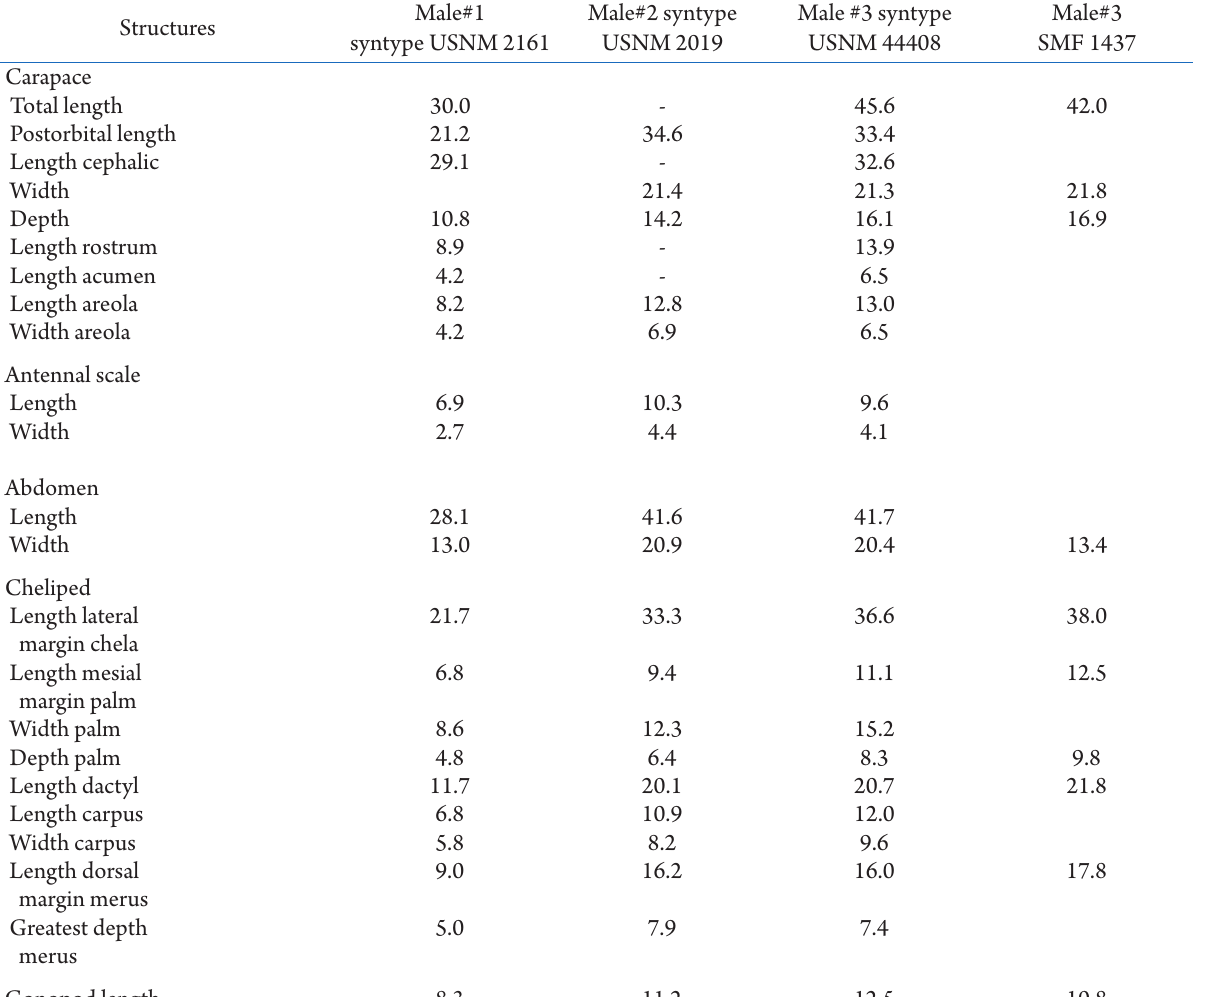
Table 1. Measurements (mm) of the syntypes of Pacifastacus leniusculus leniusculus (Dana, 1852) deposited at the National Museum of Natural History (USNM) and male specimen of P. leniusculus klamathensi s (Stimpson, 1857) deposited at the Forschungsinstitut und Naturmuseum Senckenberg